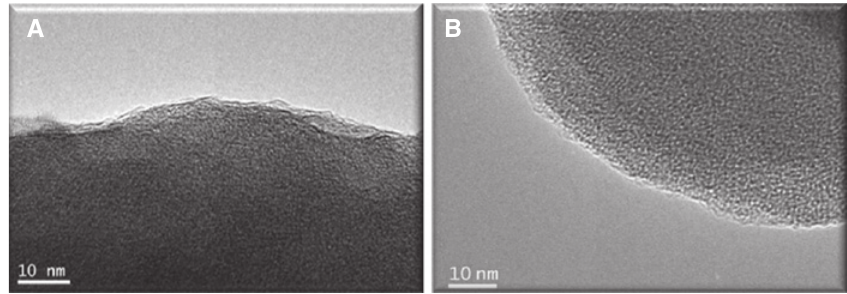
and (B) CoMoS . 2 2